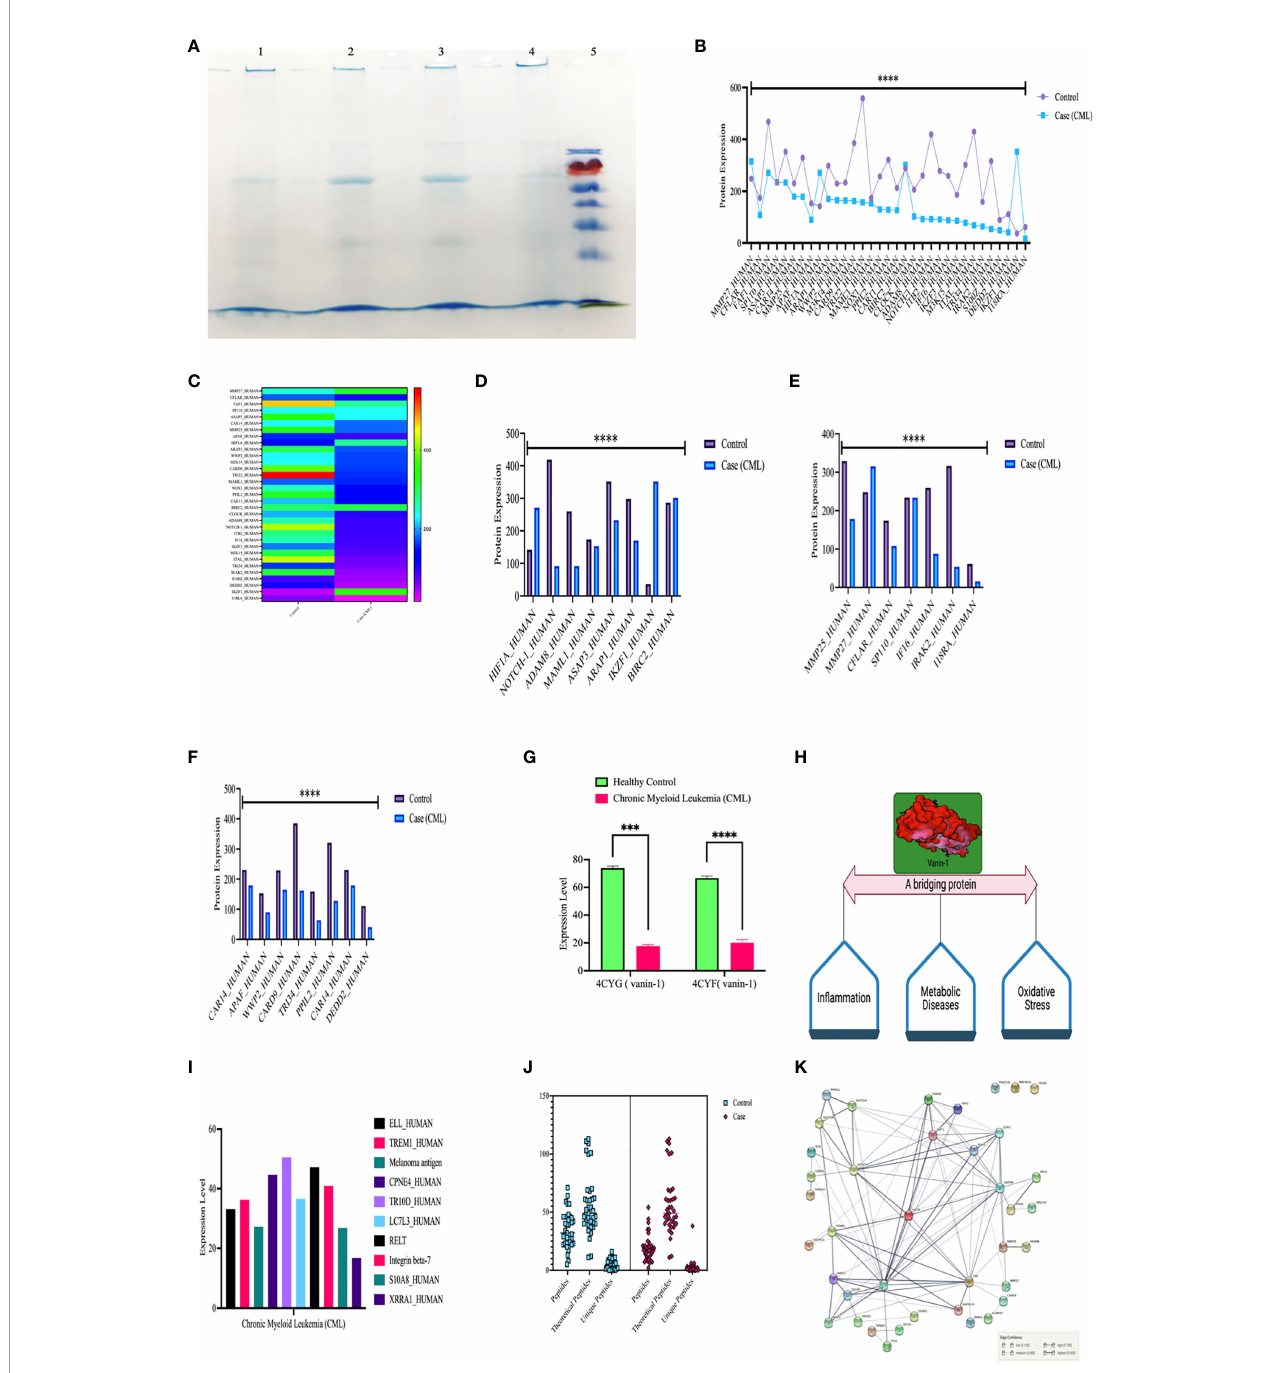
FIGURE 6 | High-throughput screening of HIF1 a , Notch1, and all the proteins in CML by LC/MSMS. (A) SDS-PAGE shows the integrity of the protein, lanes 1 and 2 show the healthy control, lanes 3 and 4 show the CML, and lane M shows the protein ladder. (B, C) Shows the 37 protein sets that are relative compared in both groups through a heatmap. (D – F) Comparison of HIF1 a , Notch1, and their associated proteins, where the graph shows that apoptotic and ubiquitin proteasomal protein sets are downregulated under CML conditions. (G, H) Vanin 1 expression was negligible in CML cases, which are connecting links between in fl ammation and oxidative stress, and their equilibrium was disrupted in blast crisis cells. (I) The graph shows the proteins that were only expressed in CML cases. (J) Estimation plot shows that the peptides of the abovementioned proteins were signi fi cantly lower under CML conditions. (K) Protein-protein interaction of all the proteins involved in this study and divided into the different domains where HIF1 a acts as a master regulator of all the genes. All quantitative data are the mean ± SD, ****p<0.0001, ***p<0.001, ANOVA and chi-square